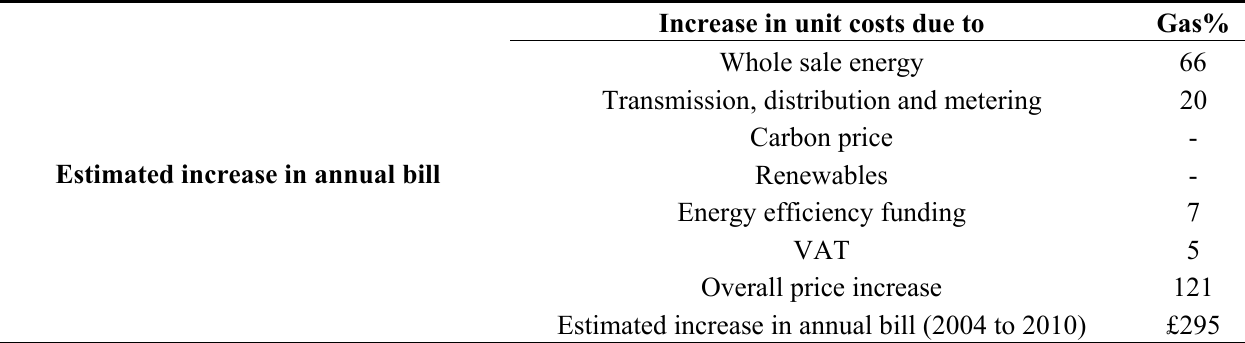
Table 6. Estimated contributory factors to domestic energy price rise February 2004 to January 2011.